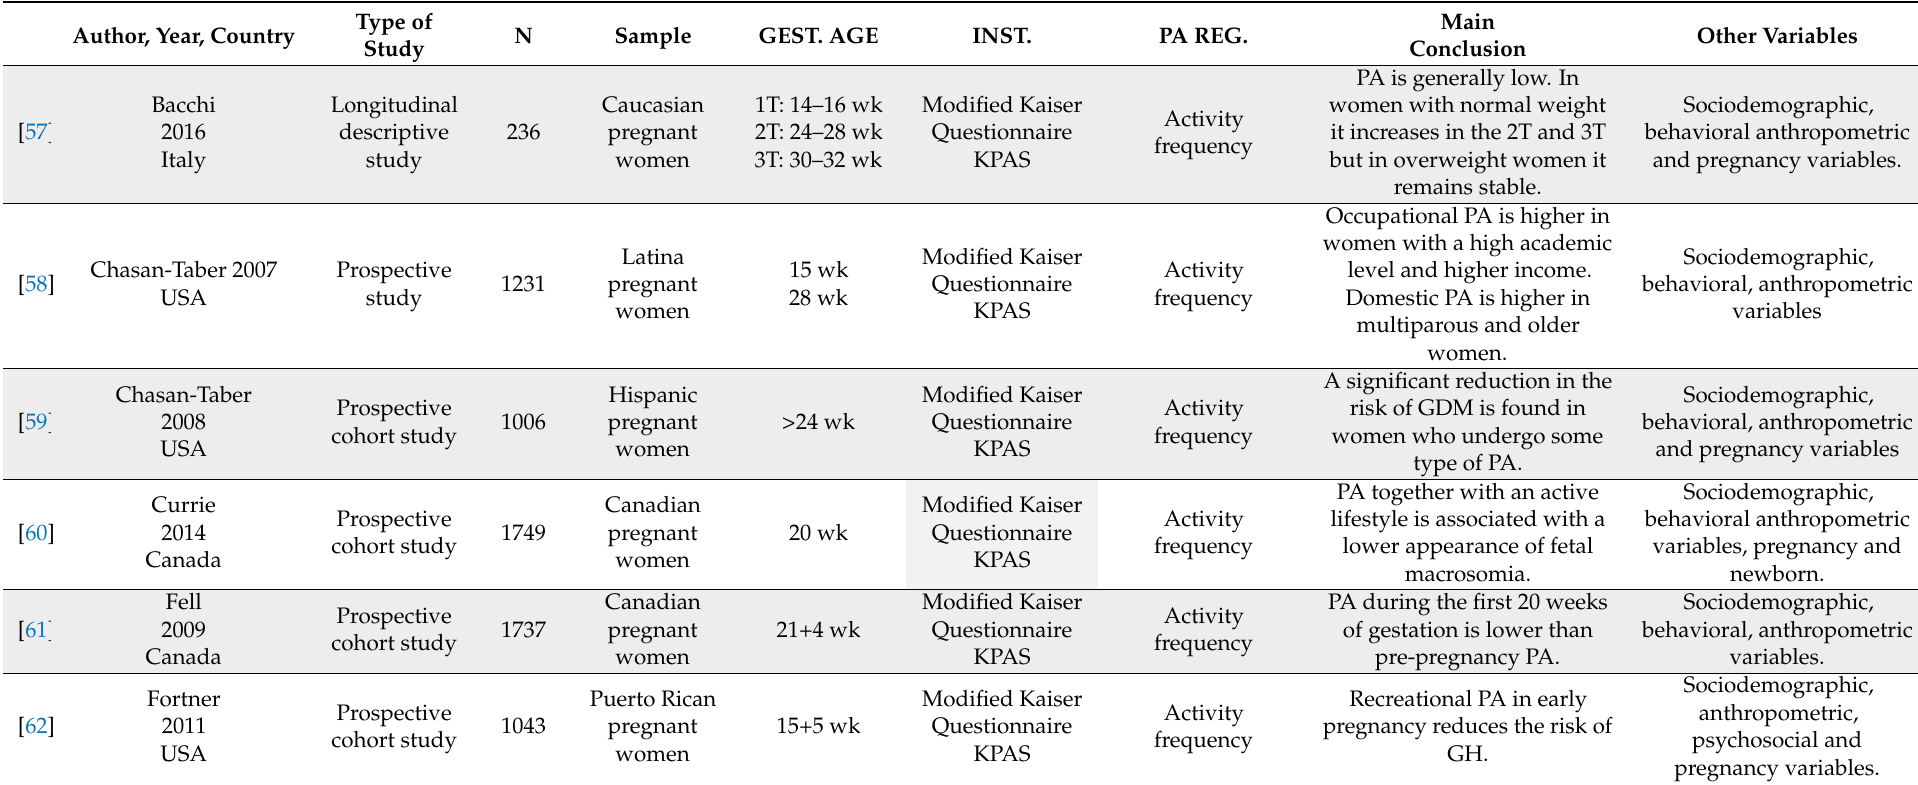
Table 5. Record of Physical Activity using the KPAS questionnaire during